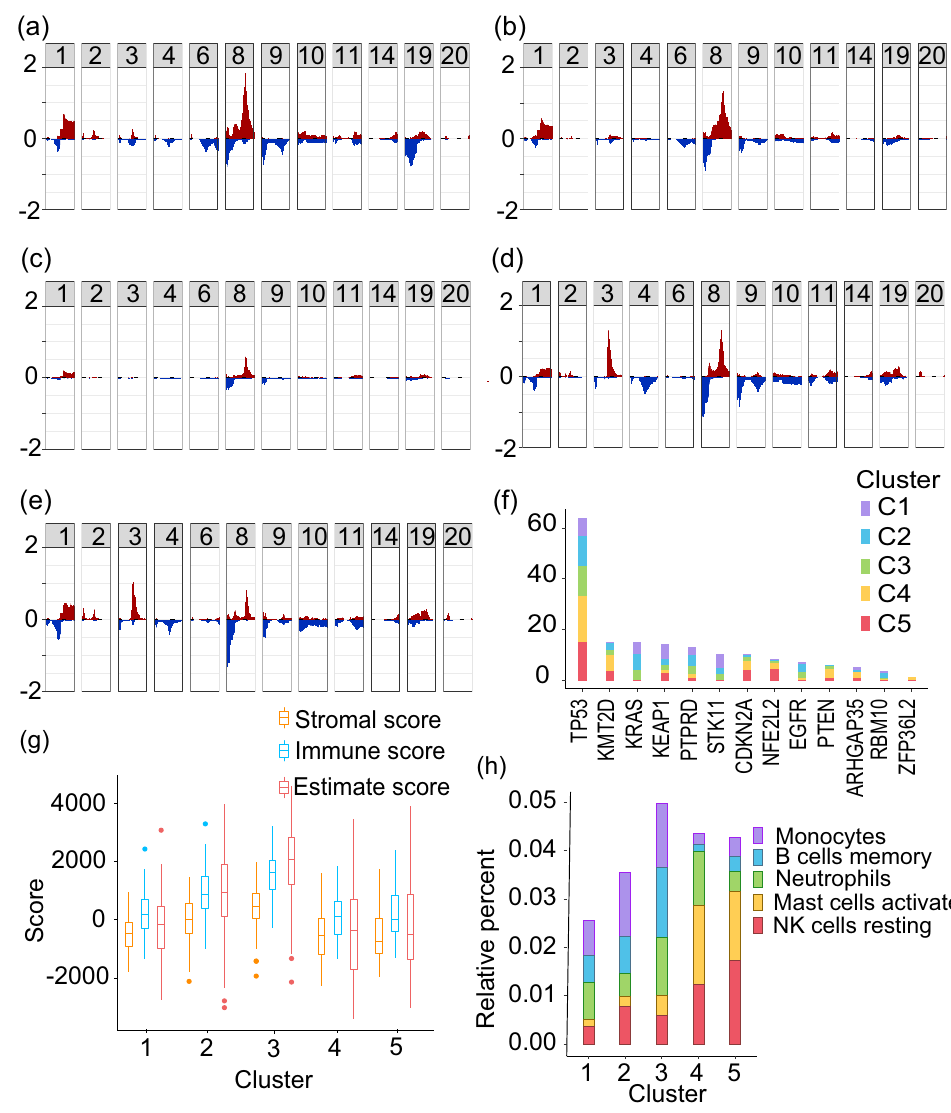
Figure 4. Molecular characters of samples with class labels obtained using consensus K -means clustering. ( a )–( e ) Frequency plots for copy number variation corresponding to clusters 1–5 (y-axis: proportion of copy number gain/loss, x-axis: Chromosome number) and ( f ) Mutation of driver genes in the subgroups. ( g ) Box plot showing the distribution of stromal, immune, and ESTIMATE scores in each subgroup. ( h ) Bar plot showing the distribution of significantly enriched immune cell types in the